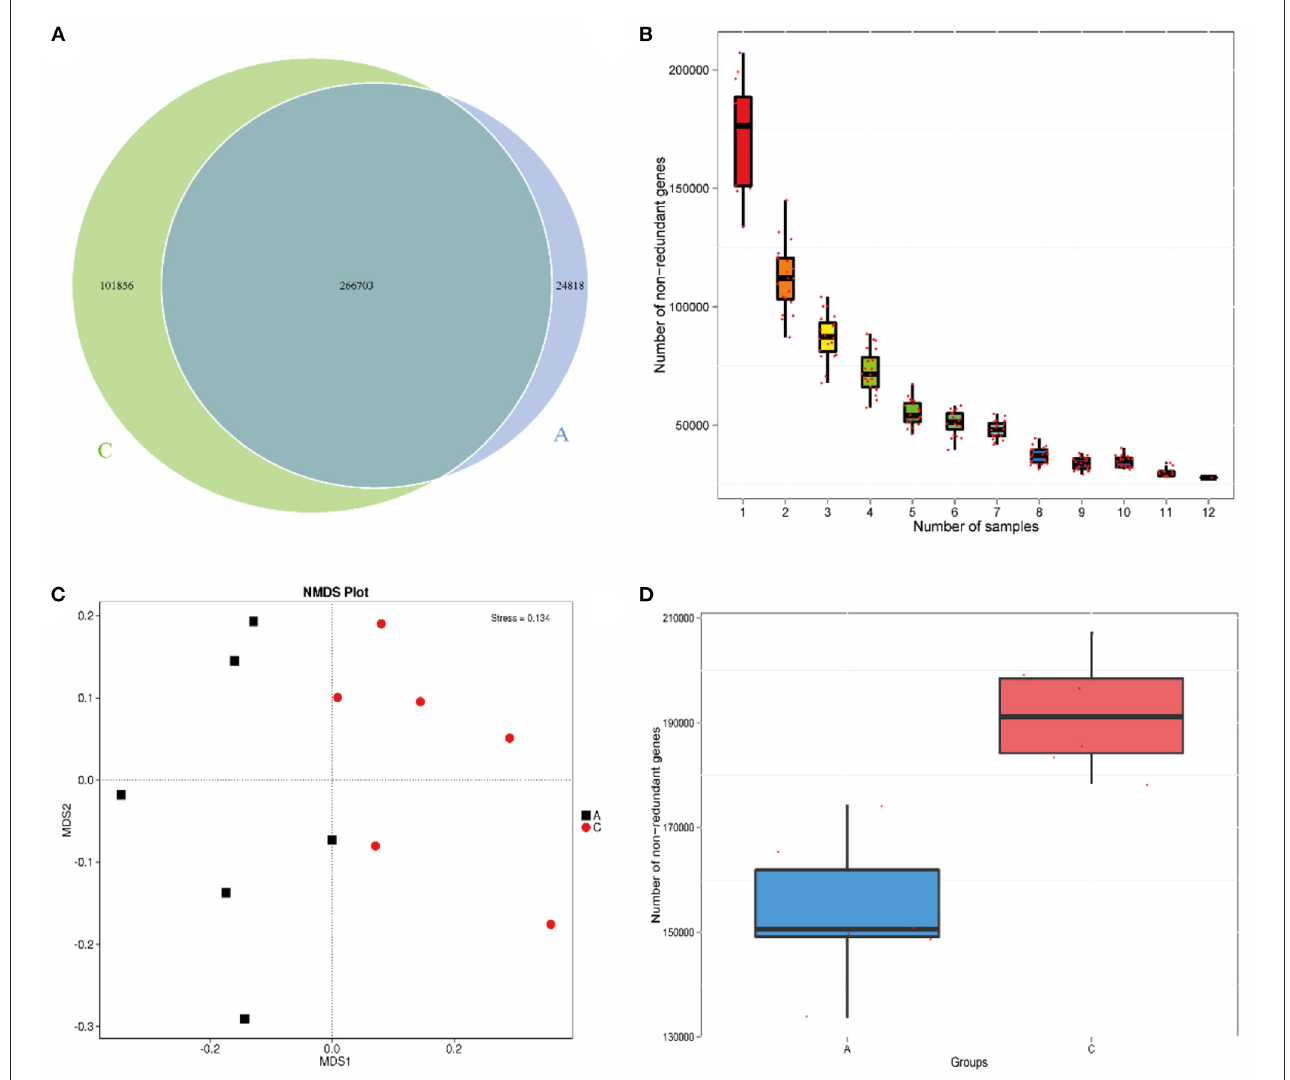
FIGURE1 Venn diagram of number of genes (A) ; Core gene dilution curve (B) ; NMDS plot based on phylum level (C) ; Box plot of gene number difference between groups (D) .